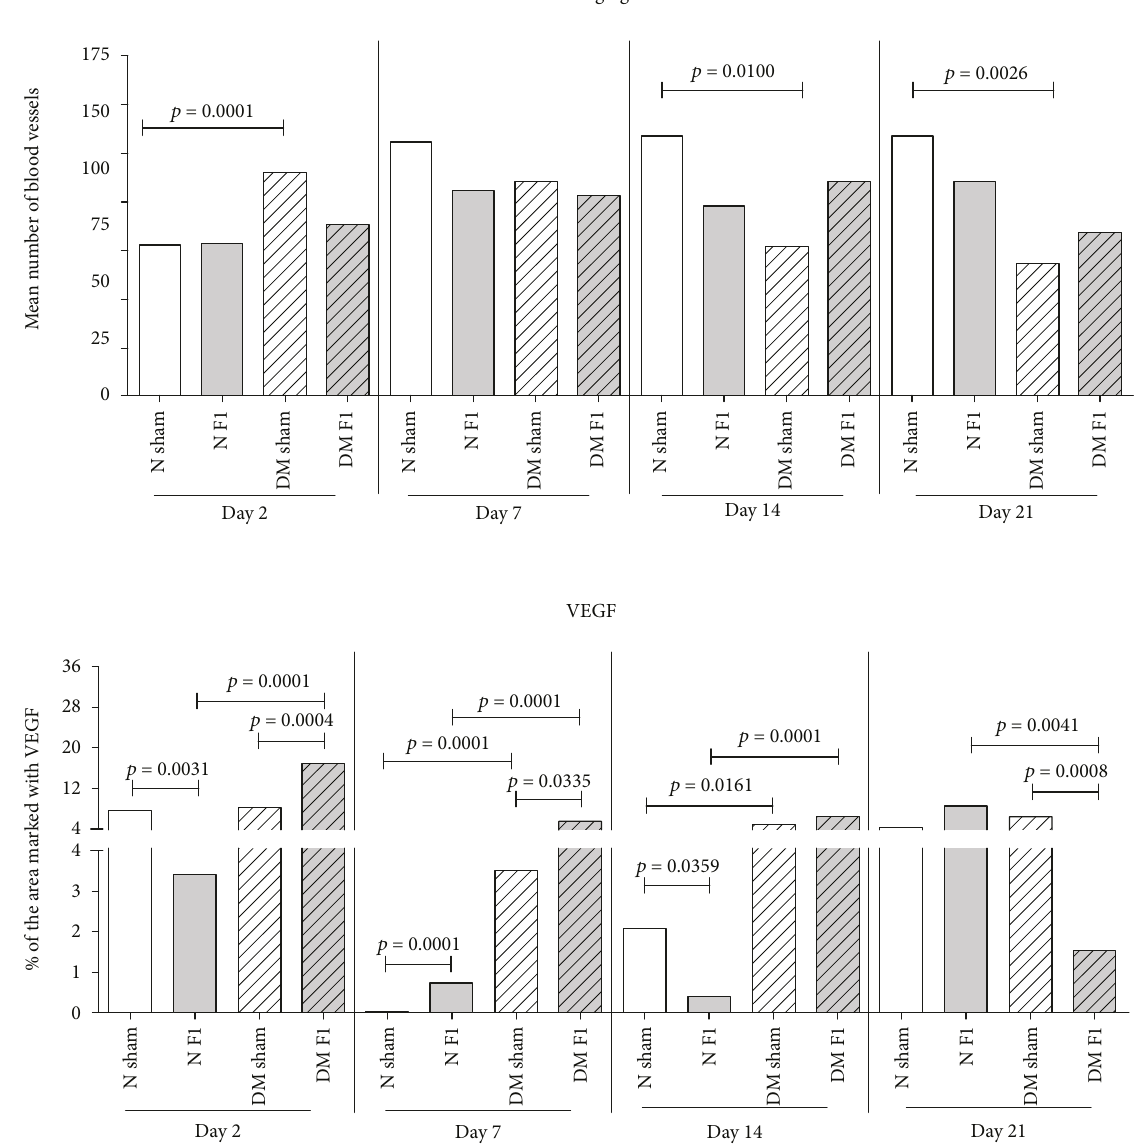
Figure 3: Characterization of angiogenesis increase and VEGF. This fi gure is adapted from Andrade [43], public